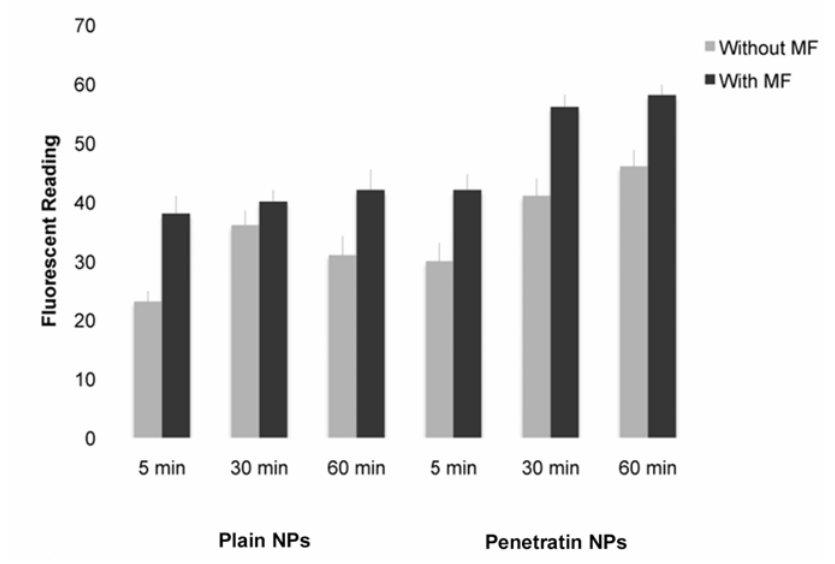
Figure 4. Assessment of 200 nm NP internalisation after 1 hour incubation as measured via fluorescent plate reader (average of n = 6 +/-sd; p < 0.001 for all significant differences described in Section 3.2.3).